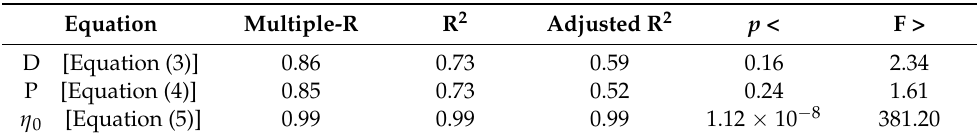
Table 2. Statistical parameters values of polynomial models found for the processing of Ti porous structures. Equation